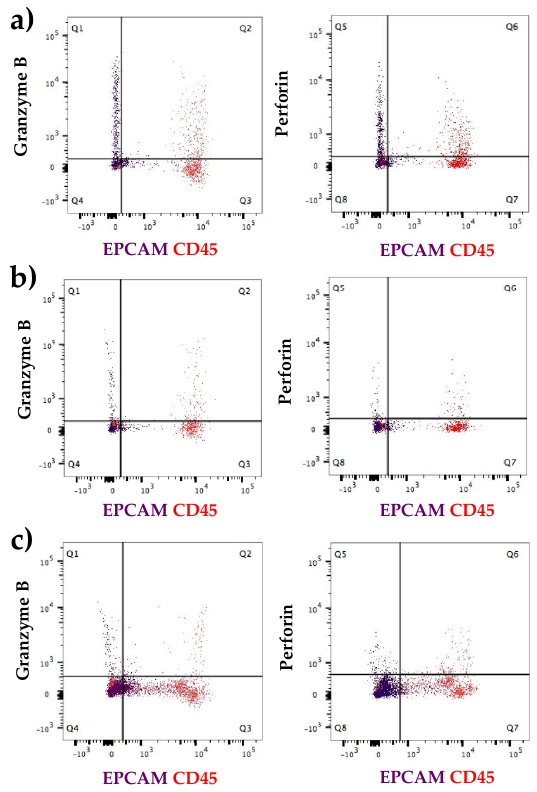
Figure 6. Flow cytometry analysis of human milk cells taken from a participant suffering from ( a ) mastitis with comparison sample of the ( b ) adjacent breast of the same participant and ( c ) compared to a healthy participant. Increased numbers of CD45 positive cells expressing of granzyme B and perforin, whereas no co-expression observed in EPCAM positive cells. Higher expression of immune proteins in CD45 cells was evident in the mastitis affected participant when compared to healthy participants.